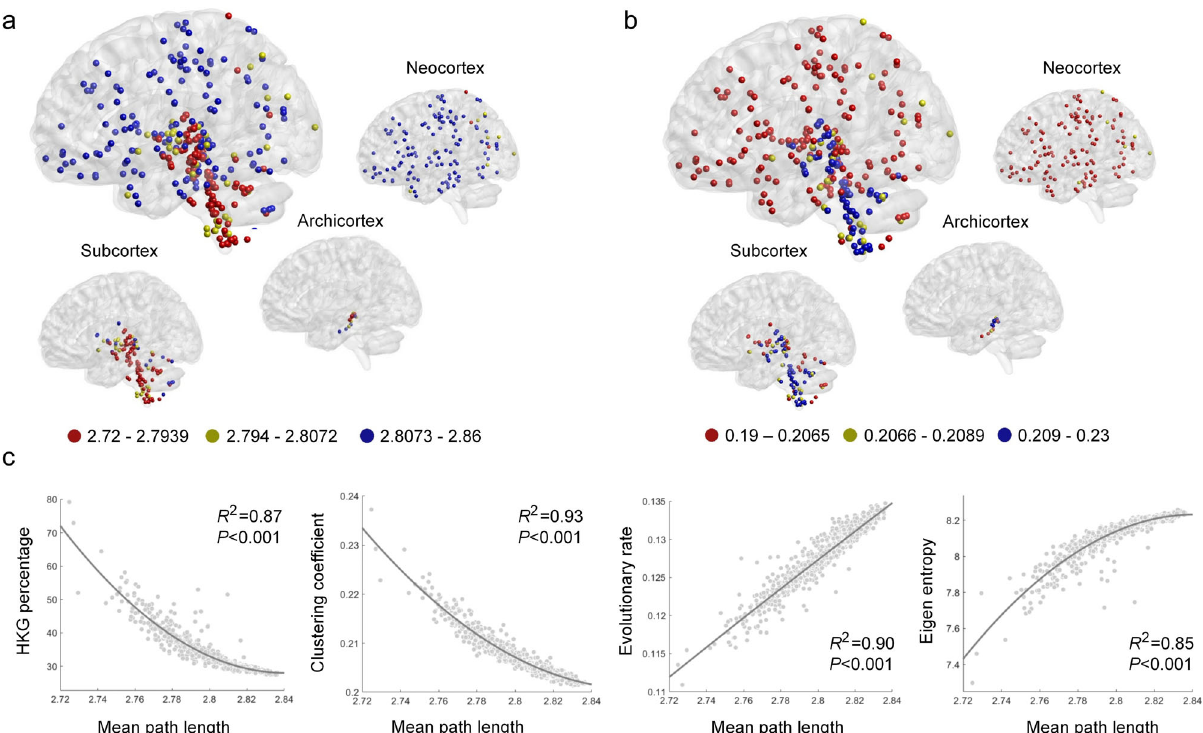
Fig. 2 Topological properties and the relationship of the gene expression networks. a The mean path length and b clustering coef fi cient mapped to all brain structures in Brain #1. The gene expression networks in the neocortex have longer mean path lengths and smaller clustering coef fi cients than those in the archicortex and subcortex. The mean path length cut-offs to best distinguish the neocortex, archicortex and subcortex of Brain #1 are 2.8073 and 2.7939, respectively, while the cut-offs of the clustering coef fi cient are 0.2065 and 0.2089, respectively. c The mean path length was negatively correlated with the HKG percentage and clustering coef fi cient and positively correlated with the evolutionary rate of expressed genes and eigen entropy of the gene expression networks in the samples of Brain #1.